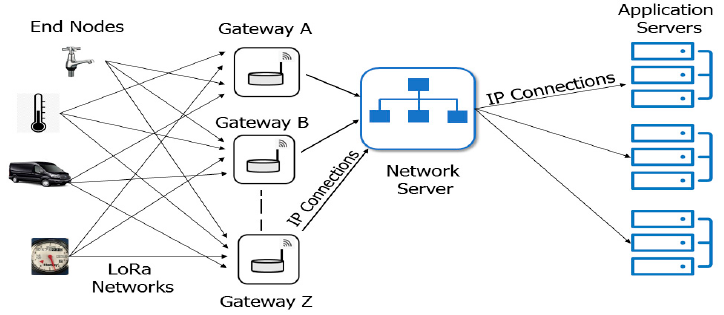
Figure 1. Structural architecture of a LoRaWAN [47].